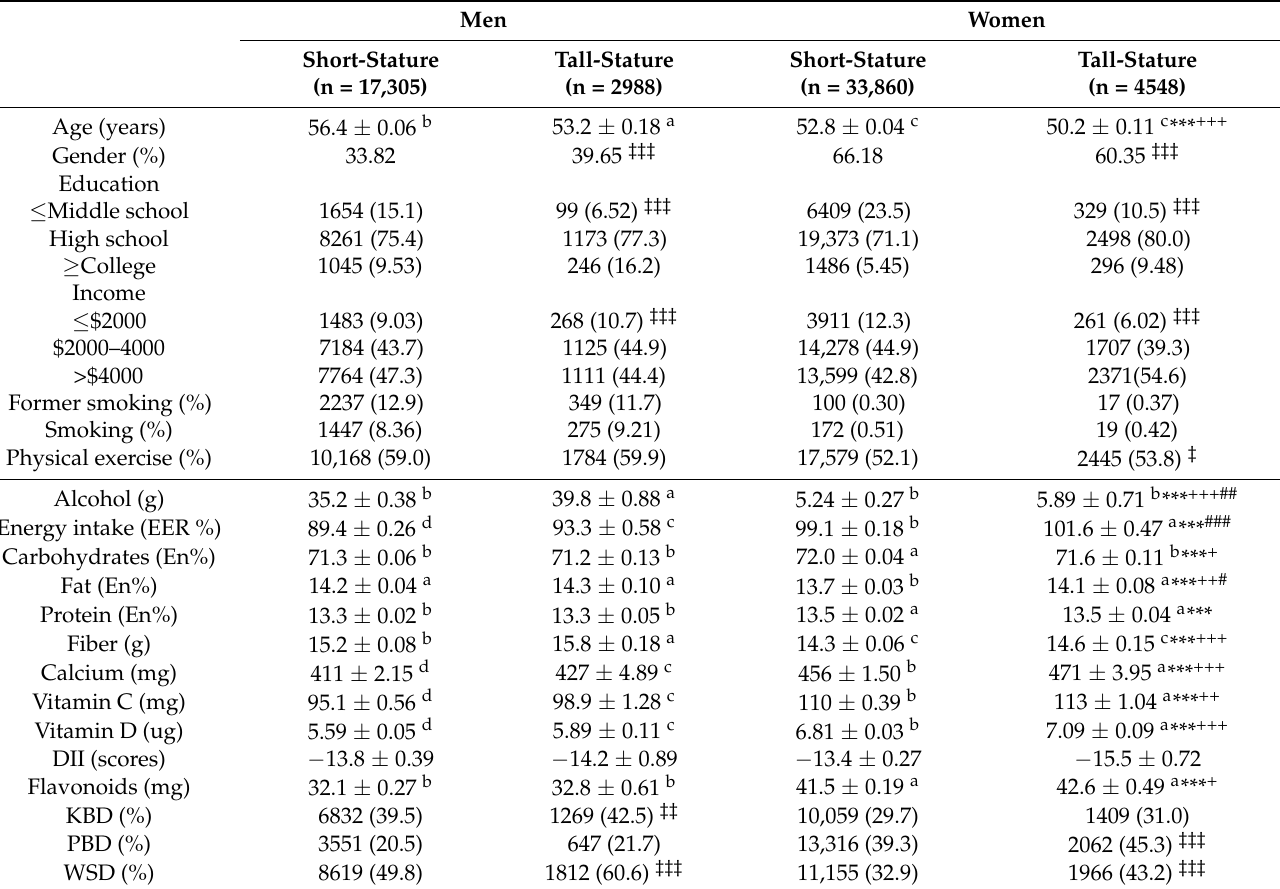
Table 1. Demographic characteristics of the participants according to gender and adult